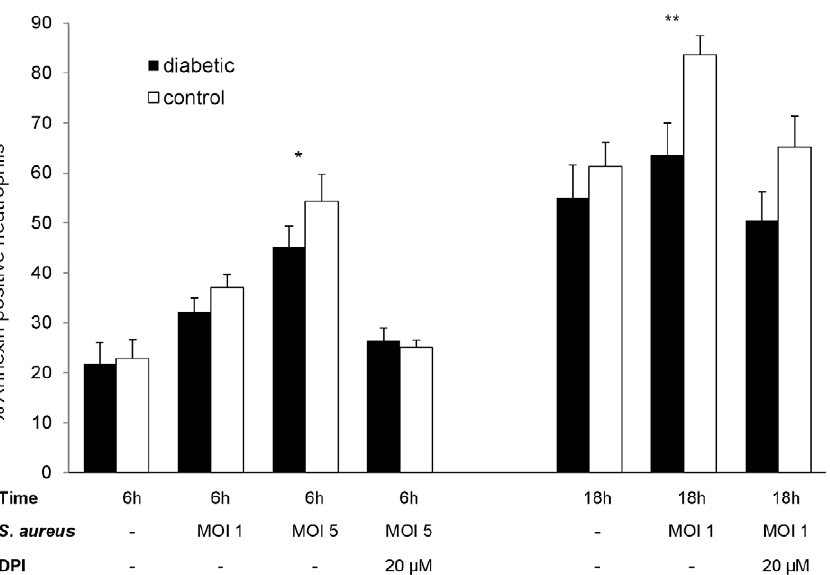
Figure 5. Neutrophil apoptosis— exvivo infection. Apoptosis of neutrophils isolated from mouse peritoneal cavities after injection of casein as a sterile inflammatory stimulus. The cells were incubated ex vivo for 6 or 18 h with or without the addition of opsonized staphylococci. In the absence of S. aureus , no significant differences in annexin binding were observed. However, at a S. aureus MOI of 1, significantly fewer neutrophils from diabetic mice were apoptotic after 18 h; an MOI of 5 resulted in significant differences between the mouse groups by 6 h. No significant differences between neutrophils from diabetic and nondiabetic mice were found (at 6 h or 18 h) in the presence of 20 m M DPI. Mean percent apoptotic neutrophils 6 SEM from 3 to 6 independent experiments are depicted. P values are calculated from pair-wise comparisons of age-matched mice, * indicates P , 0.05, ** P , 0.01.